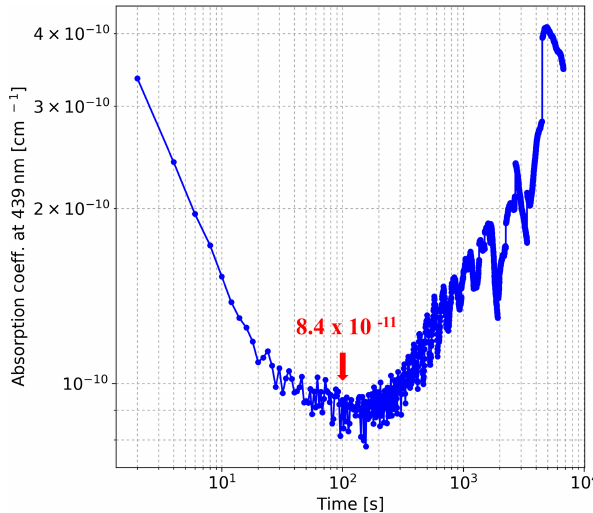
Figure 4. Allan deviation at 439nm. The precision (1 σ ) of the in- strument is 84 × 10 − 11 cm − 1 for an integration time of